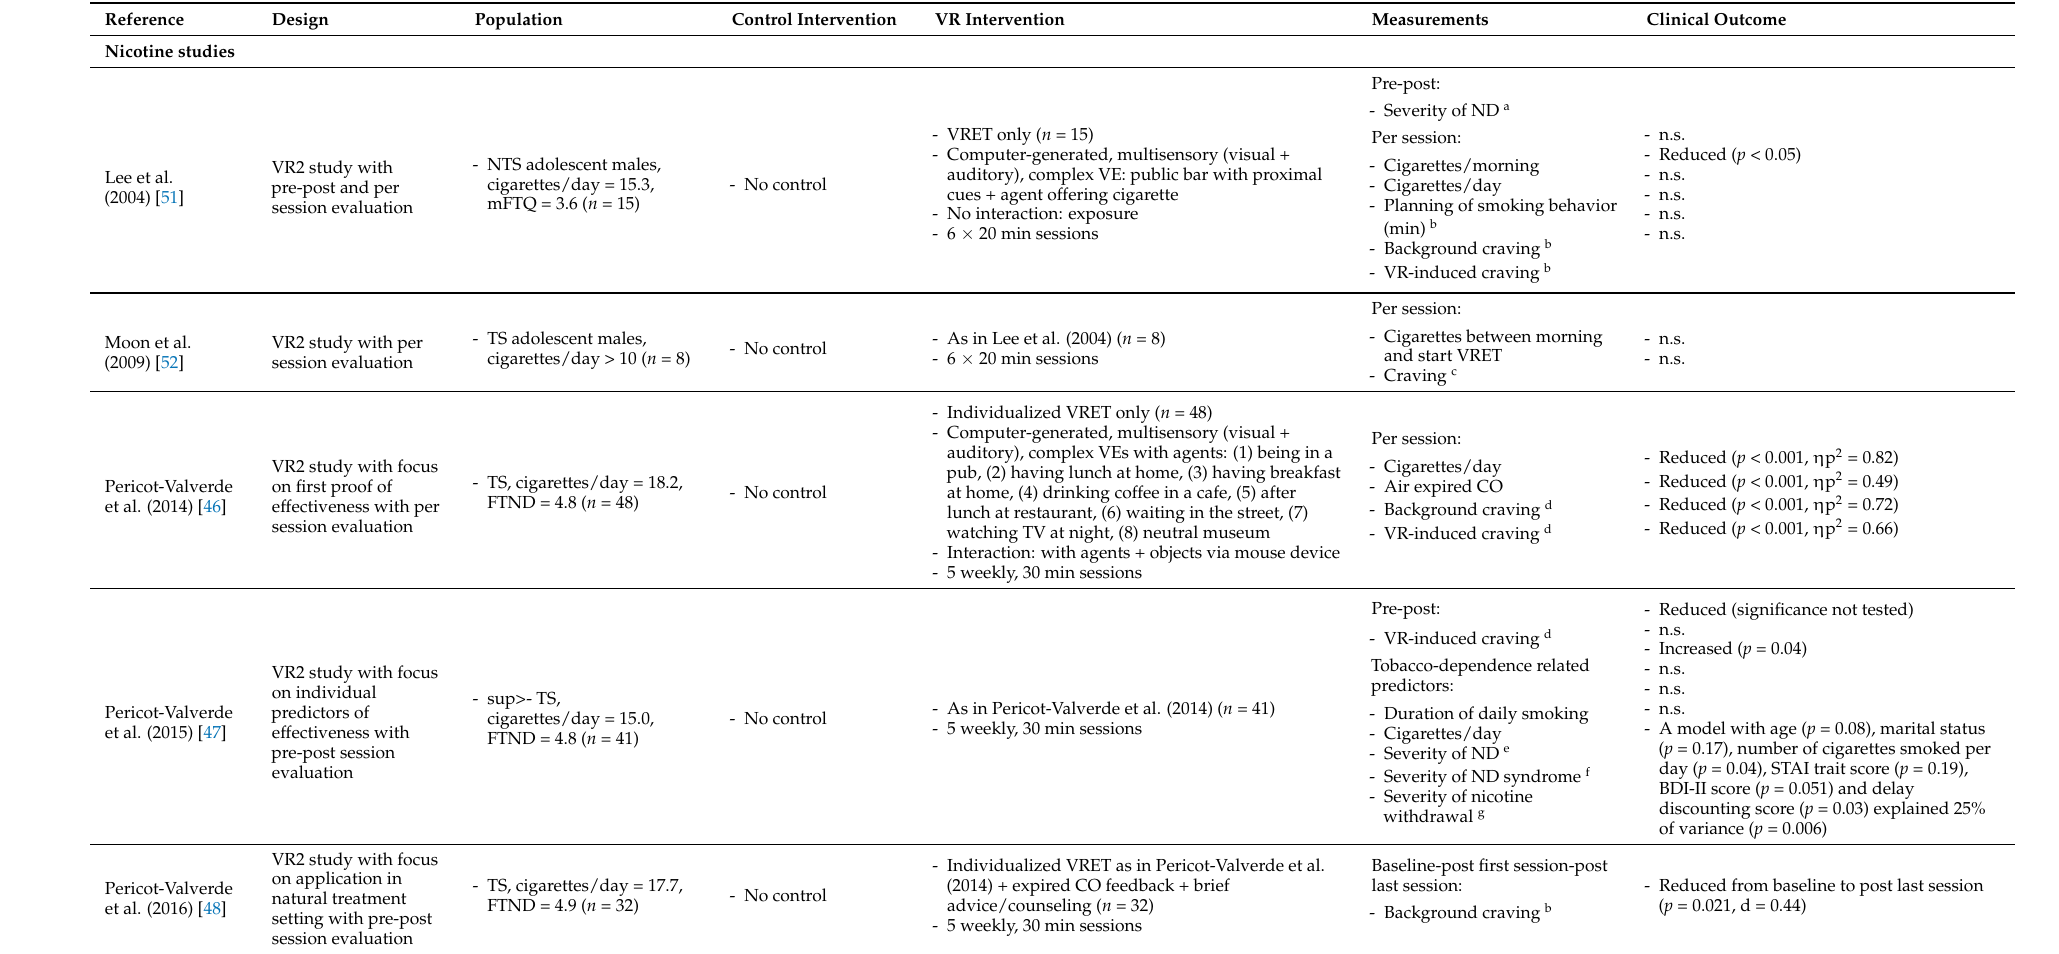
Table 3. Virtual Reality Exposure Therapy (VRET)